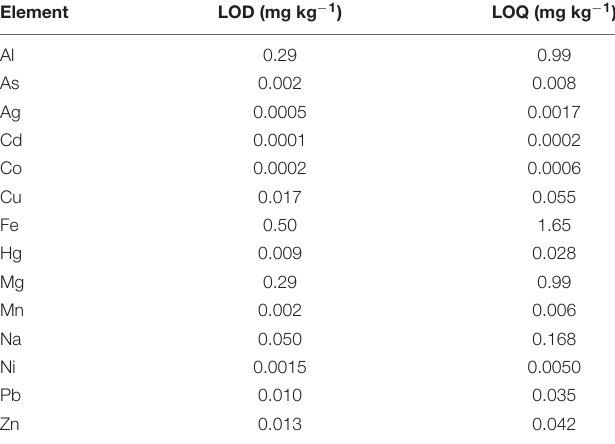
TABLE 3 | Observed and certified concentrations (mg kg − 1 ) for the ERMBB422 certified reference material and elemental recoveries (%).